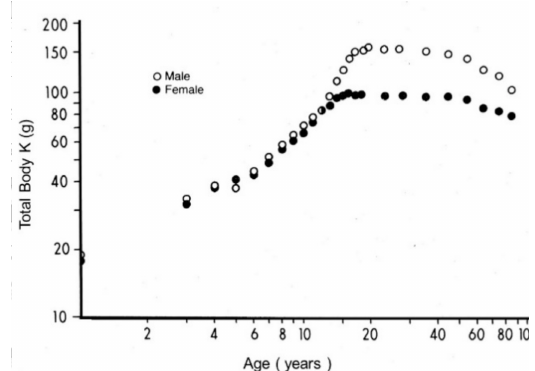
Figure 1. Body composition of average adult and elderly men. Compilation of data from various sources showing the distribution of body tissues in healthy adult subjects (20–25 years) and elderly persons (60–70 years). Fat mass (FM) is poorly hydrated and comprises the bulk of lipid stores. Lean body mass (LBM) is the sum of water, proteins, nitrogenous compounds, and mineral mass (MM). LBM devoid of its MM component yields body cell mass (BCM), which represents 57% of the LBM and comprises tissues with the richest intracellular concentrations of 39 K and the highest metabolic activities. The data indicate that the normal aging process is characterized by gradual downsizing of LBM, BCM, and MM, whereas FM shows opposite trends rising from 18% to 28% of the body weight (BW) (Adapted from Forbes 1987) [8].